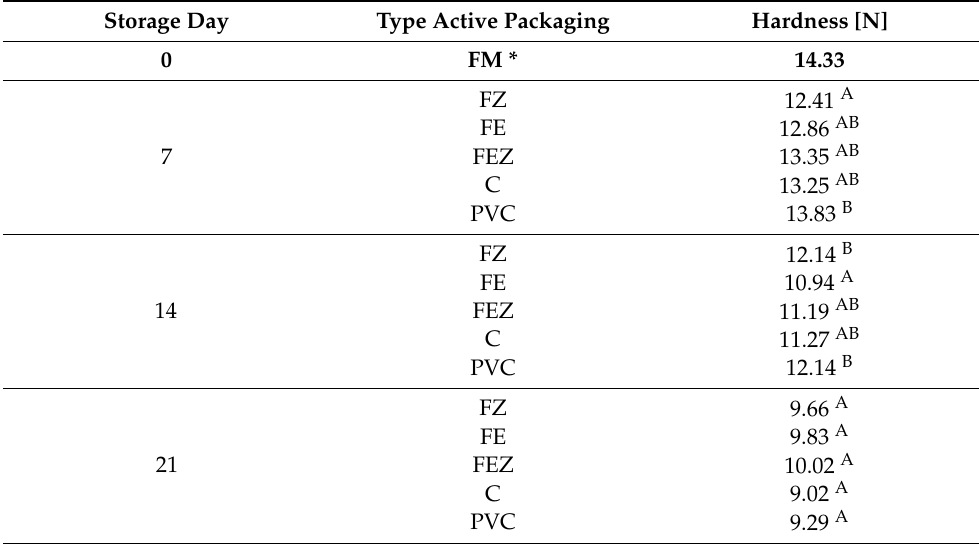
Table 1. Texture (hardness) measured in mushroom caps packed with active packaging containing zeolite (FZ), aҫai extract (FE), aҫai extract + zeolite (FEZ) packed with MAP, without active packaging in MAP (C) and wrapped polyvinyl chloride foil (PVC) on each storage day. A , B — letters mark differences between every packaging variant on the same storage day.